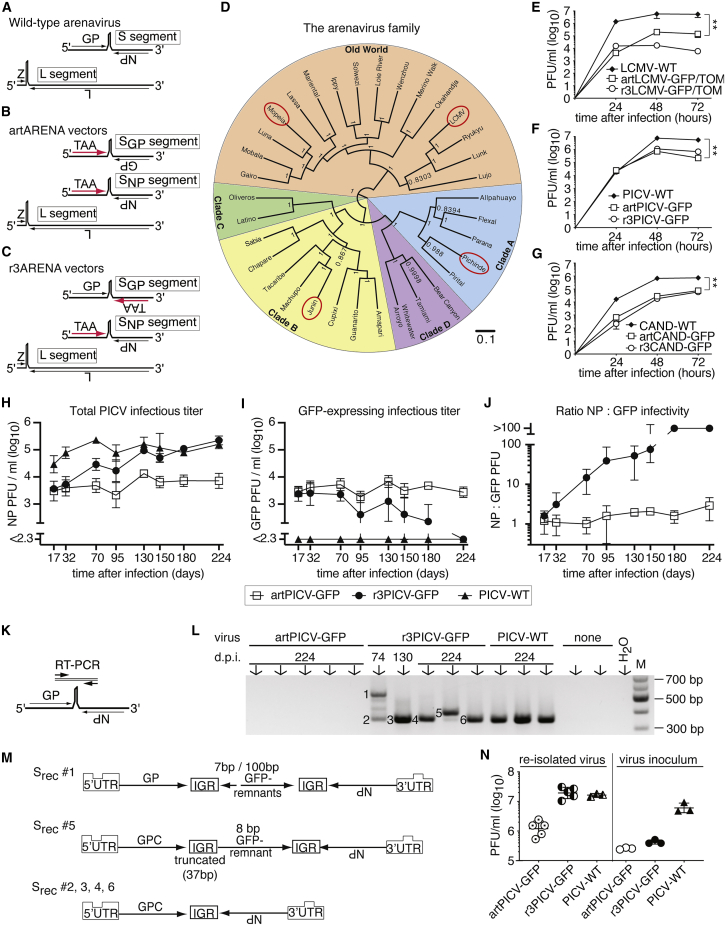
Arenavirus vector backbone candidates and their genetic and phenotypic stability(A–C) Schematic of the genome organization of WT arenaviruses (A), artARENA vectors (B), and r3ARENA vectors (C). TAA, tumor-associated antigen.(D) Genealogy tree of the mammarenavirus family with its clades. Red circles indicate viruses used in this study. The scale bar describes the expected number of mutations per site.(E–G) Growth curves of the indicated viruses and vectors in BHK-21 cells (E and F) and 293T cells (G) infected at a multiplicity of infection (MOI) of 0.01. Symbols show the mean ± SD of three cell culture wells (error bars mostly within symbol size). ∗∗p < 0.01 by unpaired two-tailed Student’s t test.(H–J) AGRAG mice were infected intravenously (i.v.) with the indicated viruses, and viremia was monitored by immunofocus assays detecting PICV-NP (H) or GFP (I) to calculate the NP:GFP infectivity ratio (J). Symbols represent means ± SD of 3–5 mice.(K–M) RT-PCR strategy (K) to amplify recombined WT-like PICV S segment RNA species re-uniting NP and GP sequences. Also shown is a gel electrophoresis image of RT-PCR products (L) obtained from serum samples collected at the indicated time points. Each lane represents an individual mouse. Sera from uninfected mice (“none”) and water were included as negative controls. Sequence analysis of the bands numbered in (L) suggested recombination products, as depicted schematically in (M). IGR, S segment intergenic region; UTR, untranslated region.(N) BHK-21 cells were infected with viruses re-isolated from individual AGRAG mice on day 224 of the experiment shown in (H)–(J) or with the viral stocks originally used to infect the animals. Titers after 72 h are shown. Symbols represent individual virus cultures from one mouse each. Mean ± SD is indicated.Number of independent datasets (N) for (H)–(N) = 2. See also Figure S1.